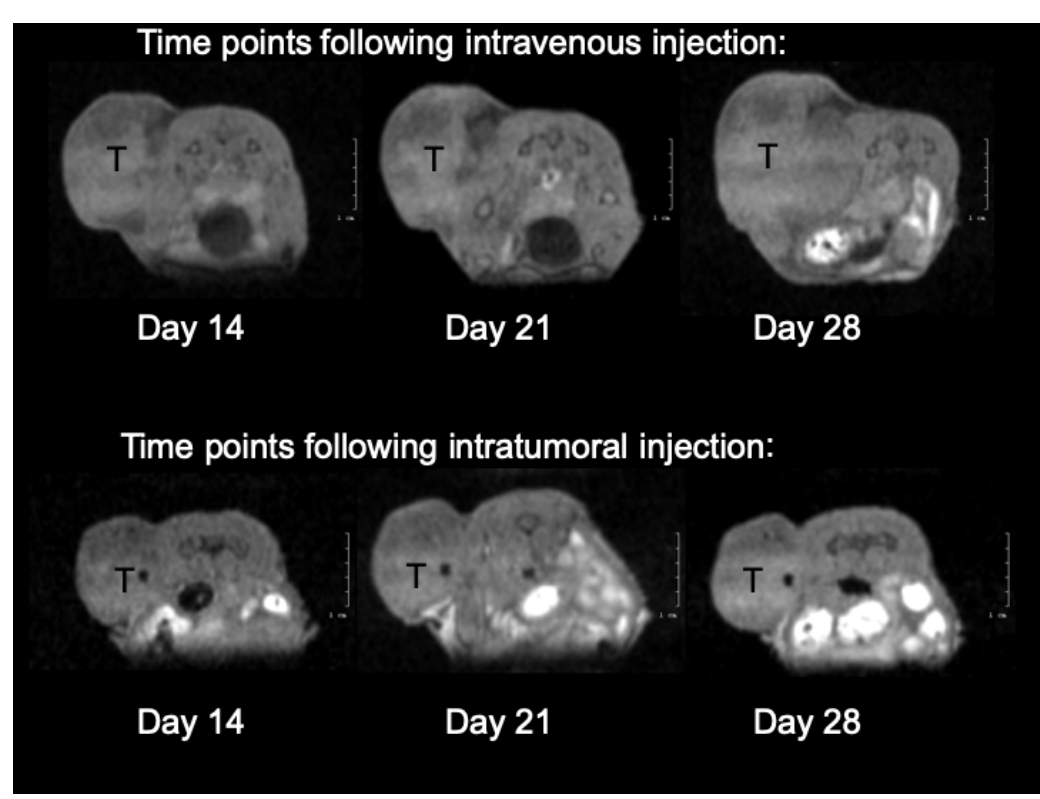
Figure 7. Illustration of mouse xenograft tumor growth through the presentation of three time points of MRI measurements with a cross-section through the tumor inoculation site. Tumors are denoted in their cross-section with a black T.